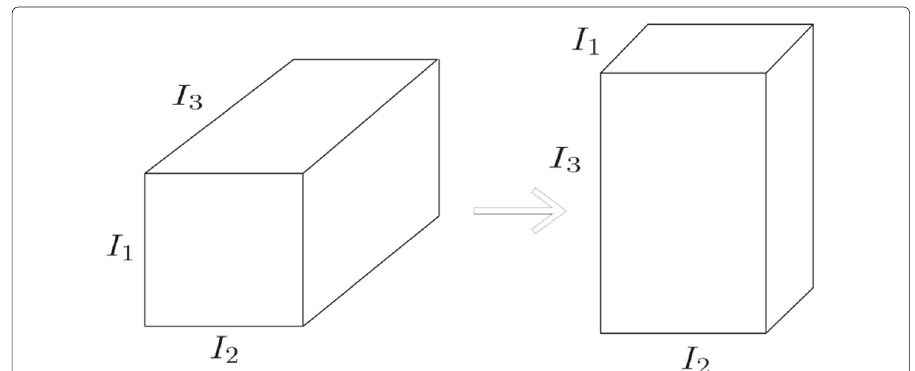
Fig. 4 Diagram of a three-dimensional tensor